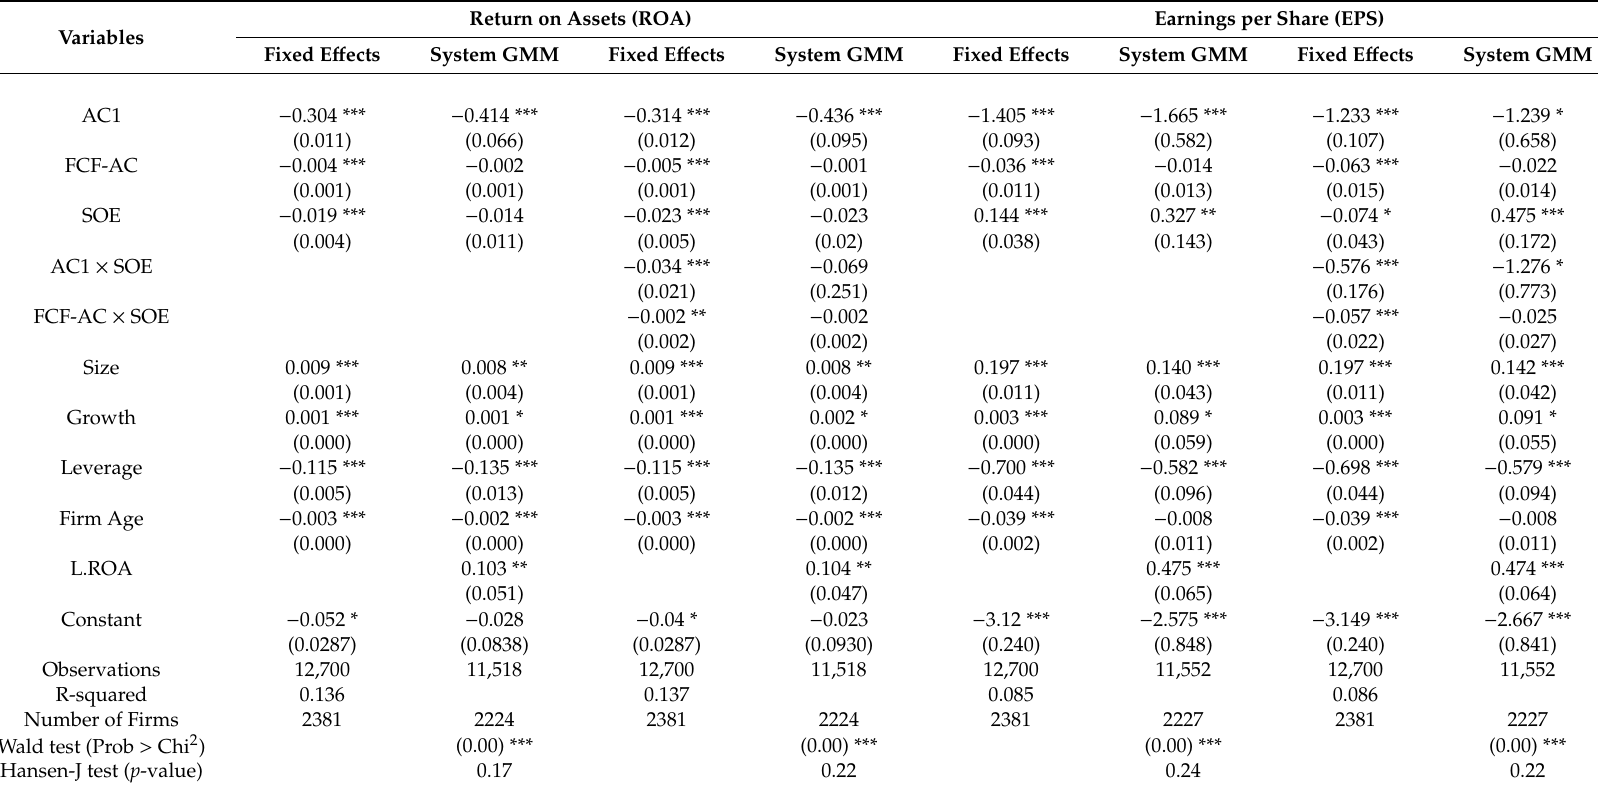
Table 8. Moderating e ff ect of ownership type (SOE) on agency costs and firm